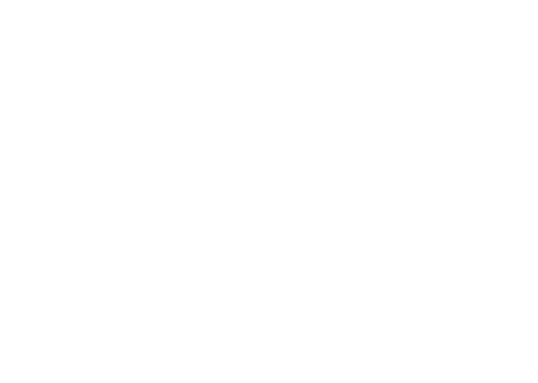
spectrometer with a CCD array (ANDOR SR-750-A-R and DU420A-UE; wavelength resolution ~0.04 nm) after passing through an optical fiber. The sample stage temperature was monitored using a thermocouple.